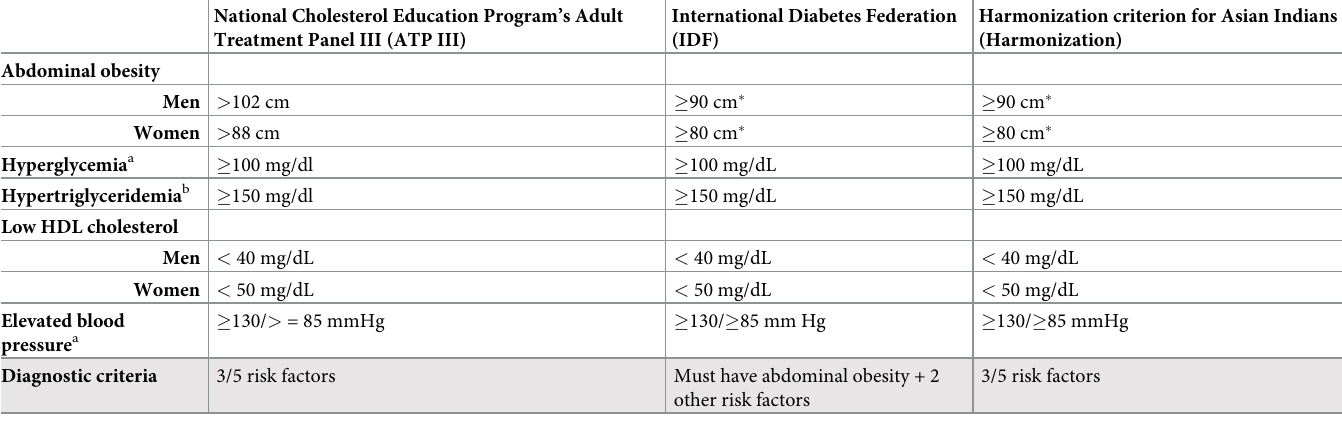
Table 1. Diagnostic criteria for metabolic syndrome for ATP III, IDF and Harmonization